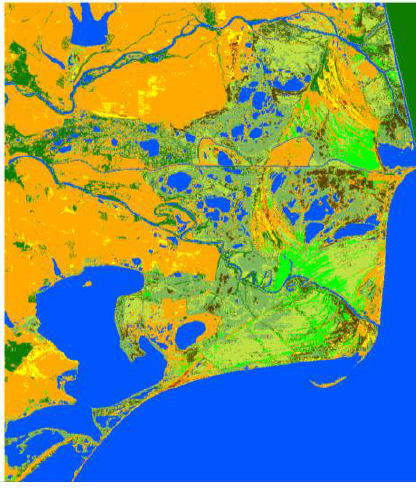
Figure 5: Random Forest Classification